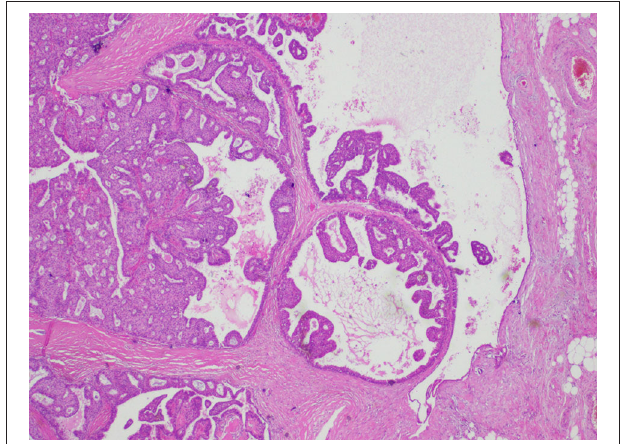
FIGURE 2 | Histological findings of encapsulated papillary carcinoma (EPC). Papillary proliferation inside the dilated